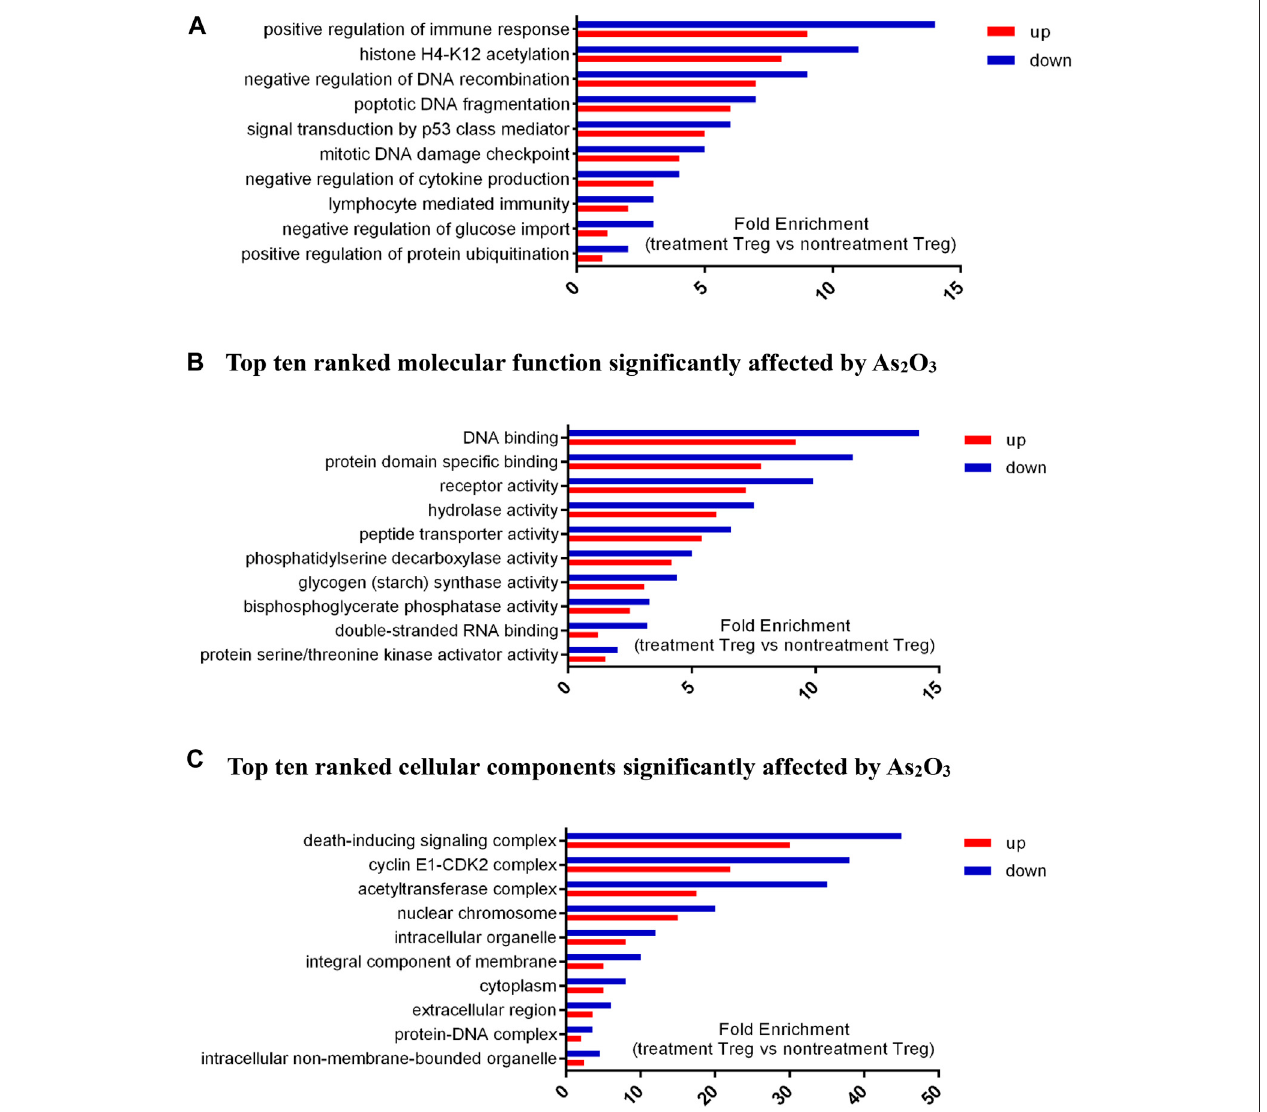
FIGURE7| Differentialexpressedgenes(DEGs)pro fi lesofGeneOntology(GO)terms(biologicalprocess,molecularfunction,andcellularcomponent)intreatment Treg cells and nontreatmentTreg cells from earlytreatment-naïve RApatients. (A) Top ten ranked biological process signi fi cantly affected byAs 2 O 3. . (B) Top tenranked molecular function signi fi cantly affected by As 2 O 3. . (C) Top ten ranked cellular components signi fi cantly affected by As 2 O 3 .